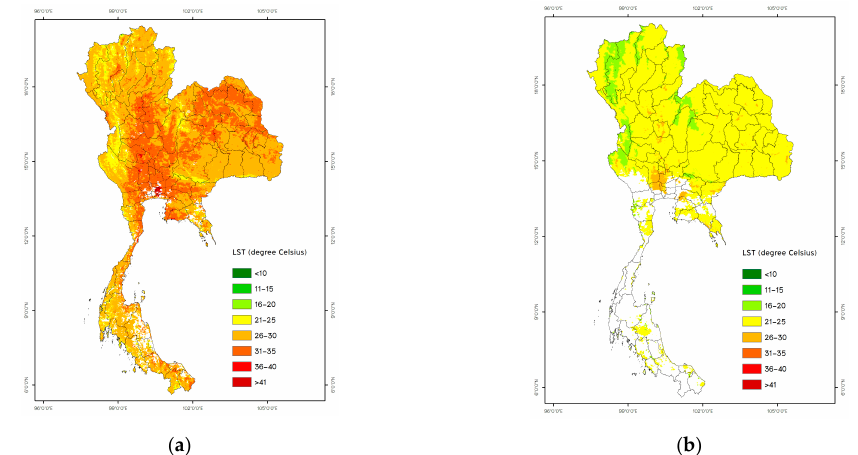
Figure 7. Examples of land surface temperature ( a ) LST—day product and ( b ) LST—night product on October 29, 2019.